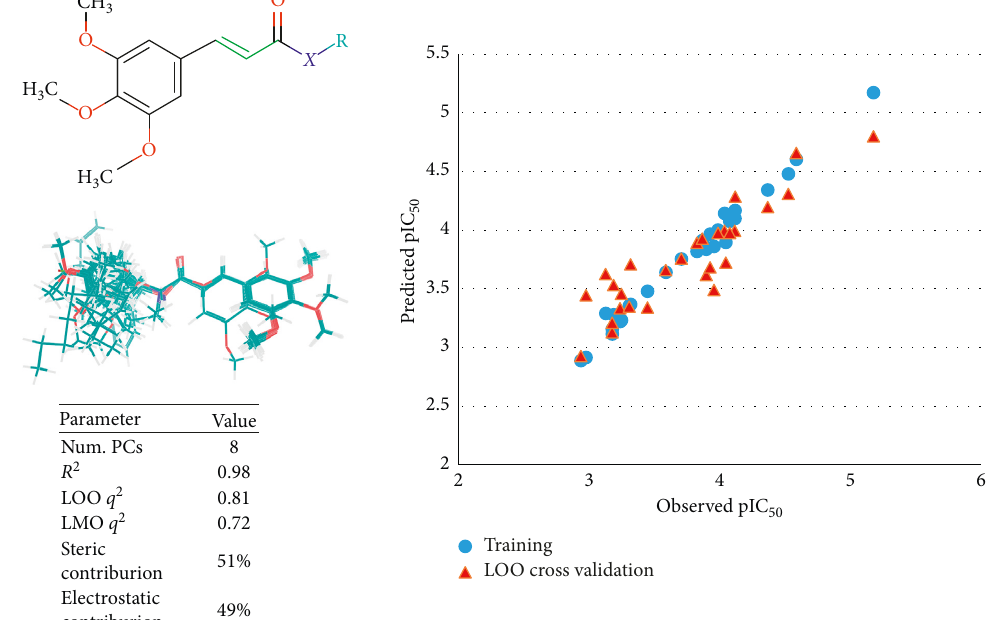
Figure 2: Summary of the QSAR modeling